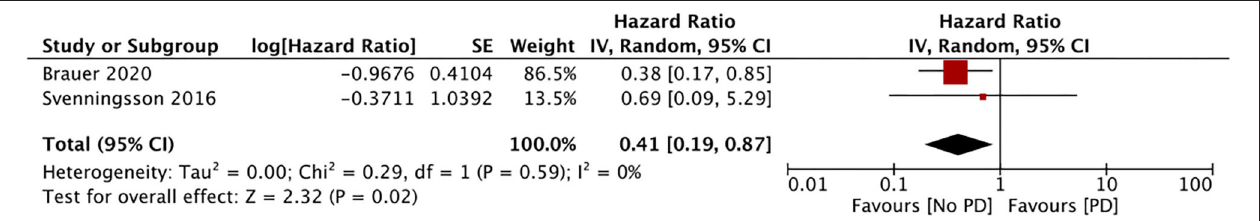
FIGURE 6 | Meta-analysis of PD risk in patients with DM using